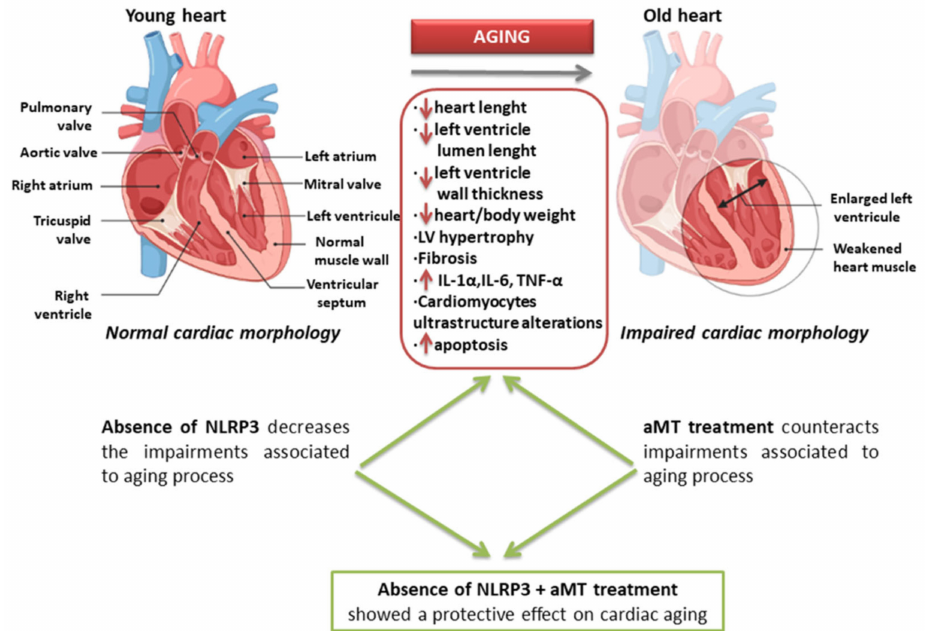
Figure 8. Schematic graph summarizing the age-associated alterations of the cardiac muscle fibers and the beneficial effects of NLRP3 inflammasome deletion and melatonin (aMT)